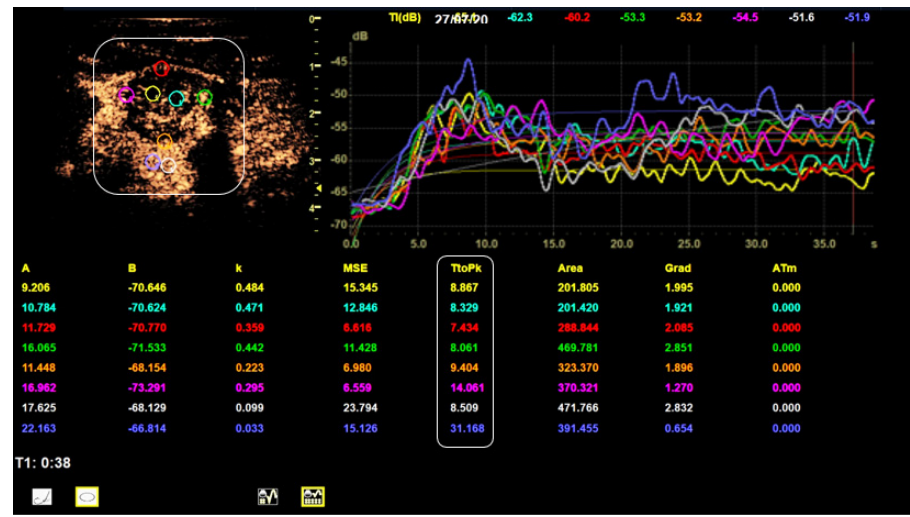
Figure 6. TIC analysis of a right thyroid lobe with thyroid carcinoma. The smoothed TICs for every ROI are depicted in the upper right corner. The measured TTP values (bottom white box) meet the calculated malignancy criteria cut-off values: The 2 central values are lower than 13.5 s and the 3 out 4 marginal values are lower than 13.1 s.